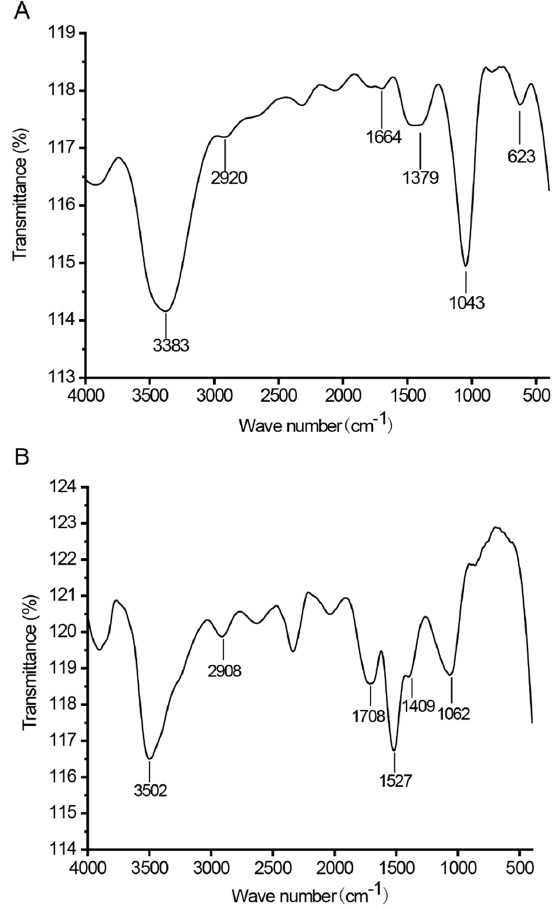
Figure 4. FT ‐ IR spectra of CTLP ‐ 1 ( A ) and CTLP ‐ 2 ( B ). Figure 4. FT-IR spectra of CTLP-1 ( A ) and CTLP-2 ( B